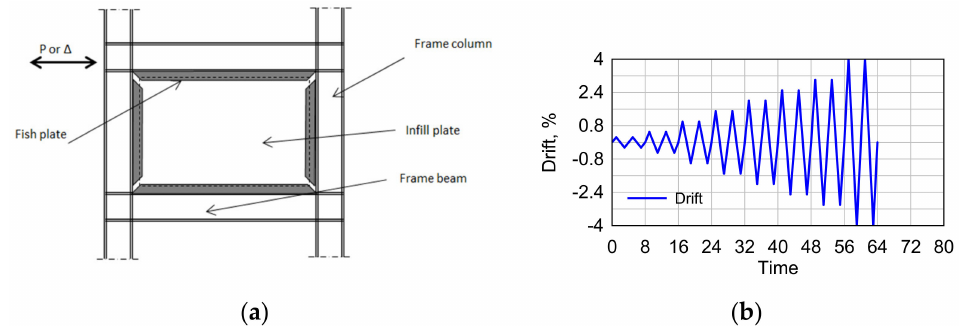
Figure 1. Geometry and loading; ( a ) typical parts of SPSW; ( b ) loading